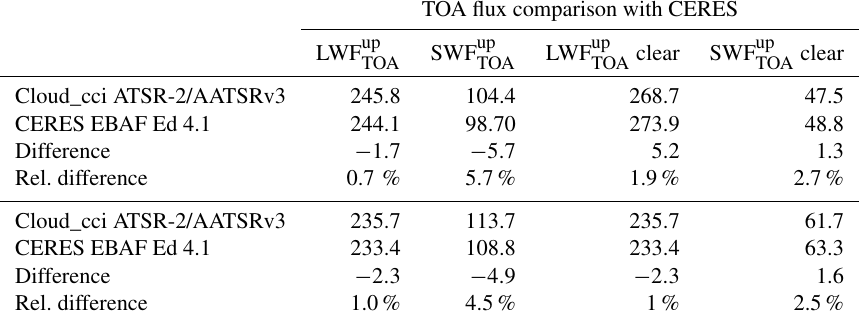
Table 7. As in Table 6 but for the bottom-of-atmosphere values (BOA).